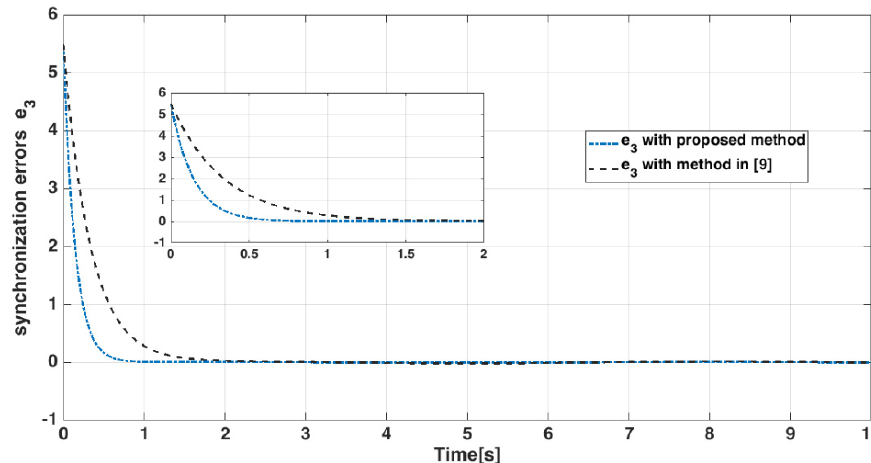
Figure 16. State errors 𝒆 𝟑 of master-slave systems